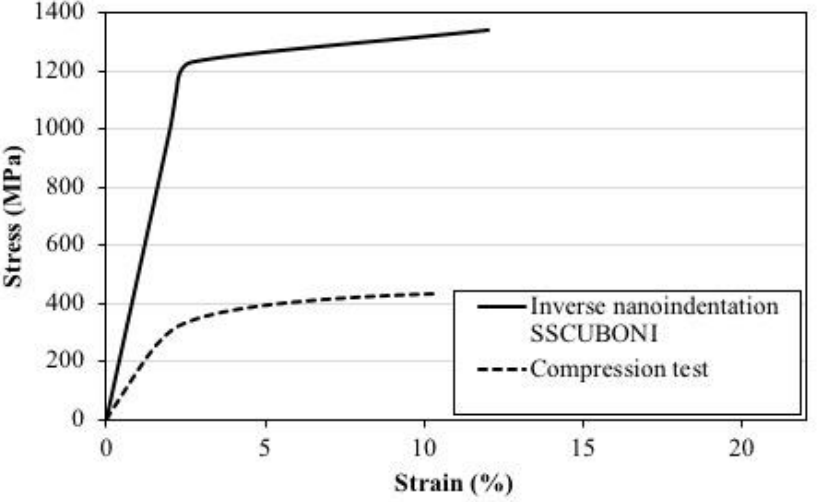
Figure 11. Comparison of the S-S curves of the experimental compression test with the corresponding inverse SSCUBONI-based experimental test for the cW-Cu specimens.